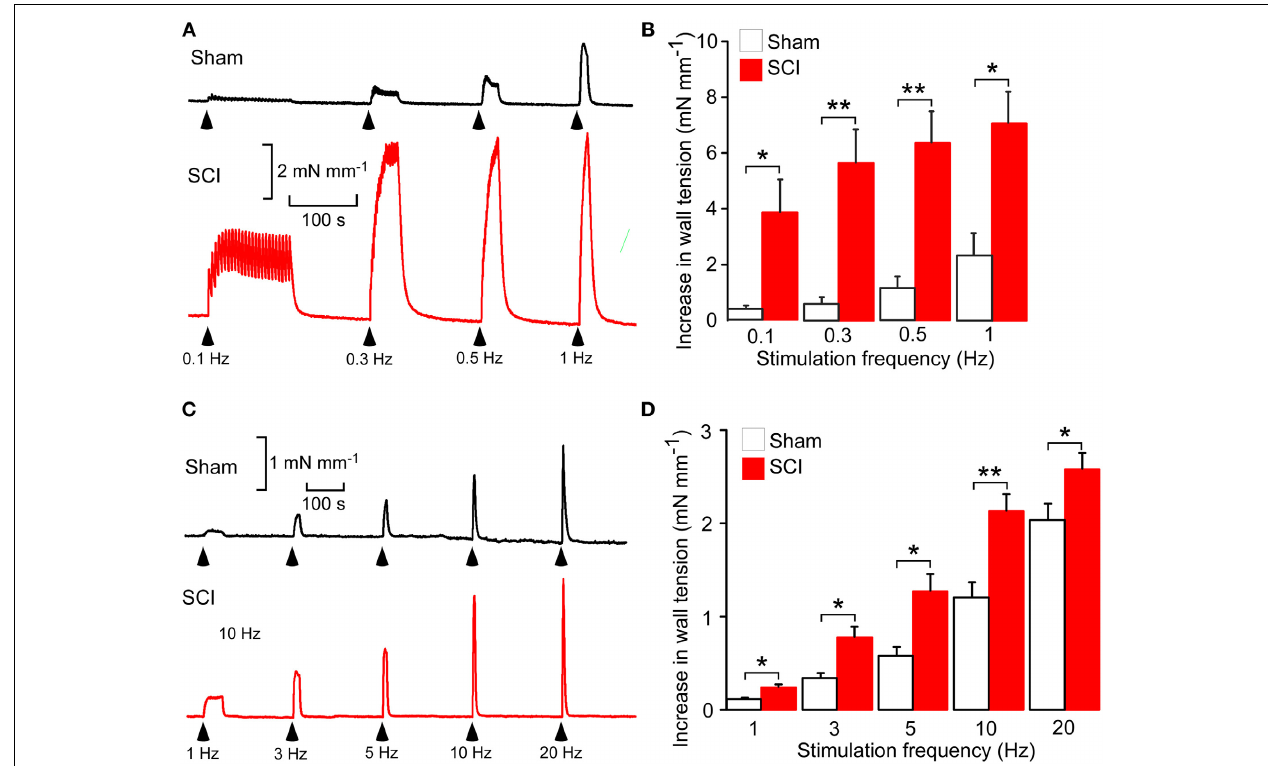
FIGURE 1 | Spinal cord injury (SCI) increased nerve-evoked contractions of both tail and mesenteric arteries. (A) Representative traces showing contractions of a tail artery segment from a sham-operated ( black trace ) and a SCI ( red trace ) rat evoked by 25 stimuli at 0.1, 0.3, 0.5, and 1Hz. (B) Peak increases in wall tension produced by these trains of stimuli in tail arteries from sham-operated ( white bars , n = 8) and SCI ( red bars , n = 8) rats. (C) Representative traces showing contractions of a